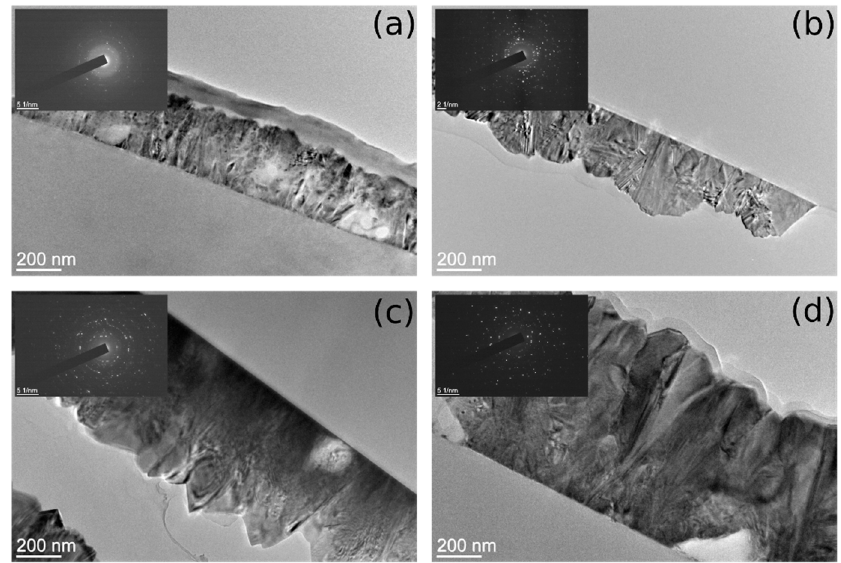
Figure 1. Cross-section TEM images of SnO 2 samples: ( a ) S-610 ( b ) S-590, ( c ) B-610 and ( d ) B-590. Corresponding SEAD patterns are shown in the insets. The average thickness and RMS roughness (calculated as standard deviation of the surface border distance from the SnO 2 layer—glass interface) calculated from the TEM images are: ( a ) (308 ± 18) nm, ( b ) (270 ± 40) nm, ( c ) (582 ± 51) nm and ( d ) (811 ± 36) nm.